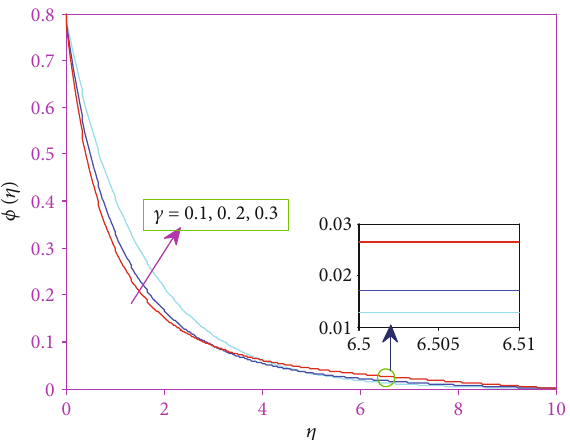
Figure 24: Concentration distribution for di ff erent values of the curvature parameter.